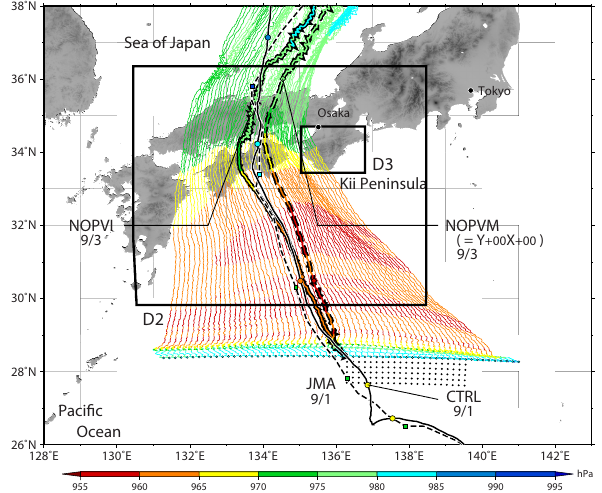
Figure 2. Computational domains 2 and 3 in the present study (except for the CTRL experiment) and the tracks of Typhoon Ta- las (2011) from the best track data provided by JMA (black dashed line with squares) and CTRL (black solid line with circles). Col- ored symbols represent the sea-level pressure of the typhoon at 00:00UTC every day. A total of 61 solid colored lines are given by Y + 00 X + ii when − 30 ≤ ii ≤+ 30, including NOPVM ( ii = 0), which is indicated by the thick line bordered by the dashed black line, and NOPVI which is displayed as the thick line bordered by the solid black line. A total of 105 black dots are given by the initial location of Y + jj X + ii when 0 ≤ ii ≤+ 20 and − 5 ≤ jj ≤−